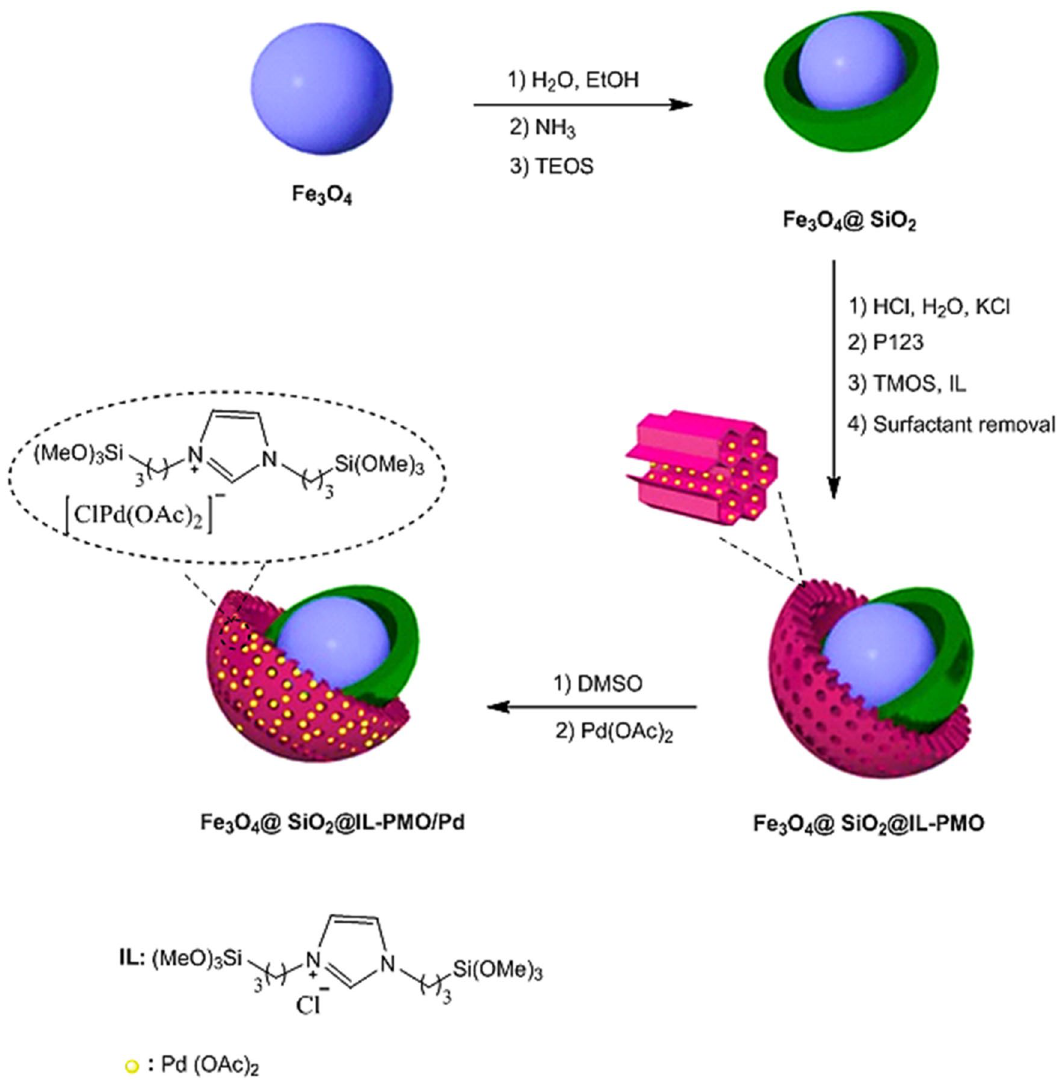
Figure 1. Preparation of Fe 3 O 4 @SiO 2 @IL-PMO/Pd.